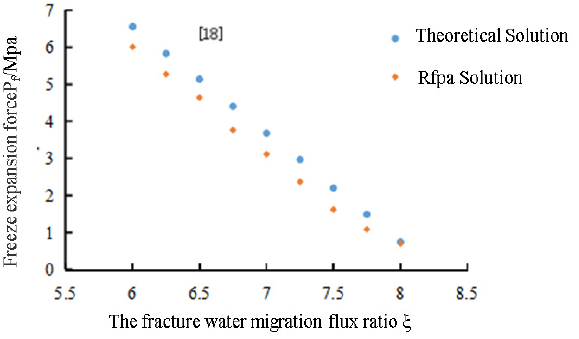
Figure 13. Comparison between the numerical and analytical solutions of frost heave pressure.